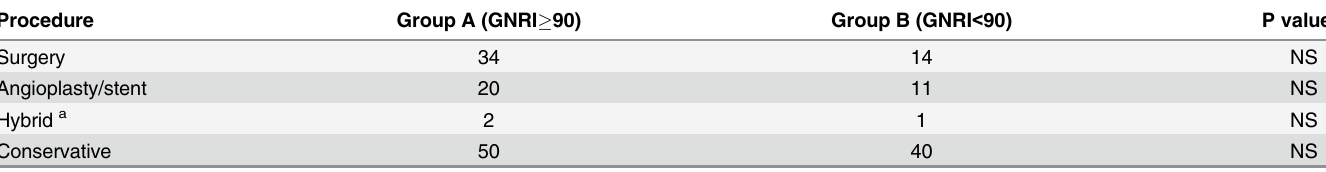
Table 2. Procedure comparison in group A and B.